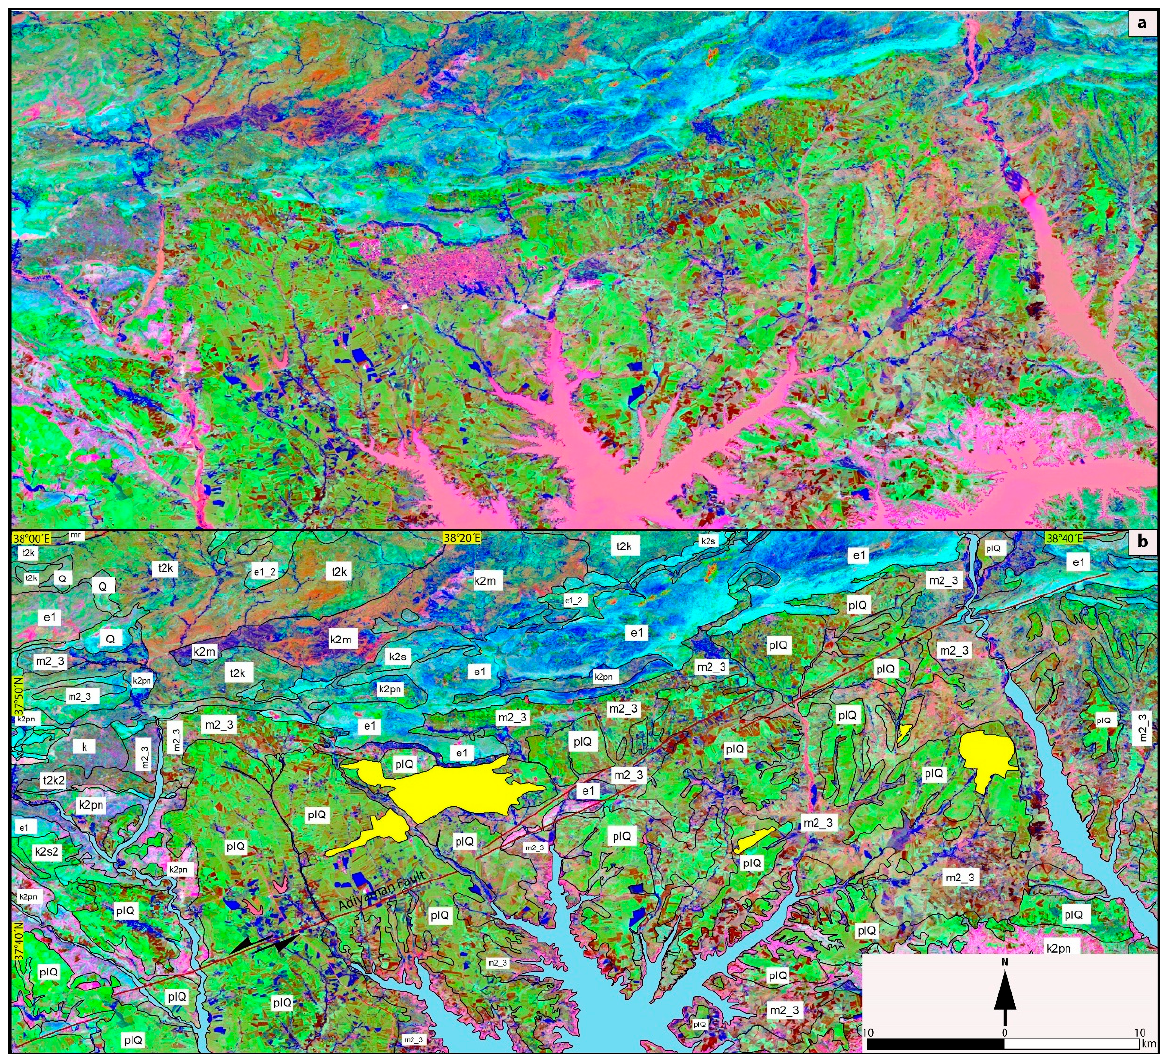
Figure 4. ( a ) Landsat 8 principal component analysis RGB-231 image. ( b ) PCA image with lithological polygons. Areas of settlements are defined by yellow polygons.